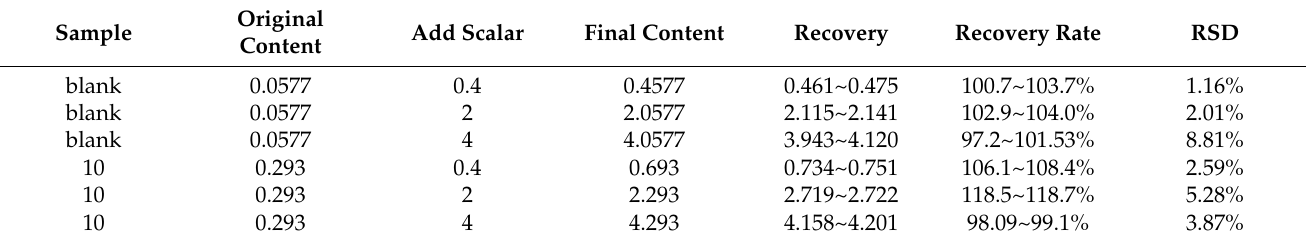
Table 6. Recovery of fluorescent probe detecting Zn 2+